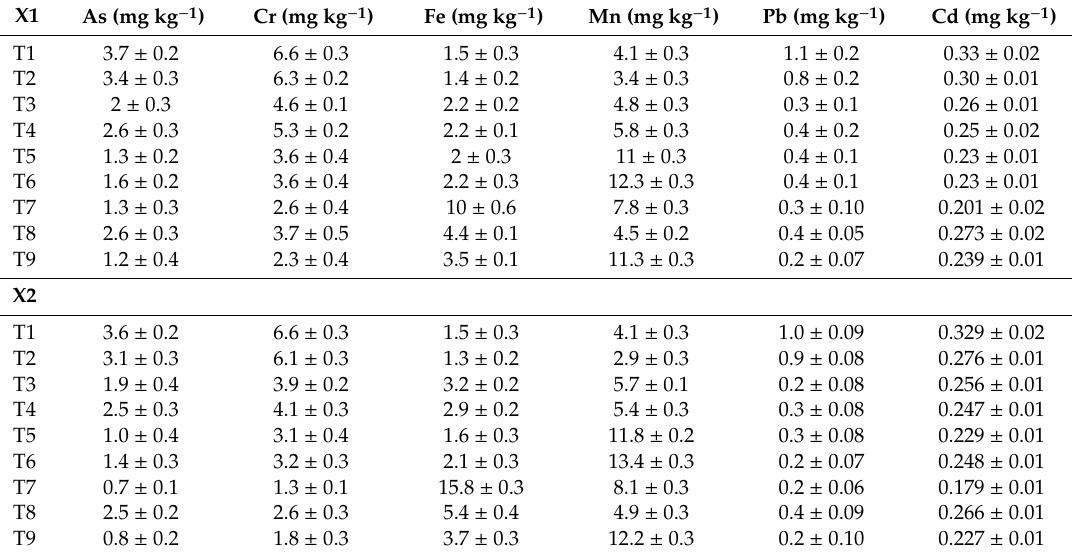
Table 3. Mean value and standard error of total elements (mg kg − 1 ) in rice plants.